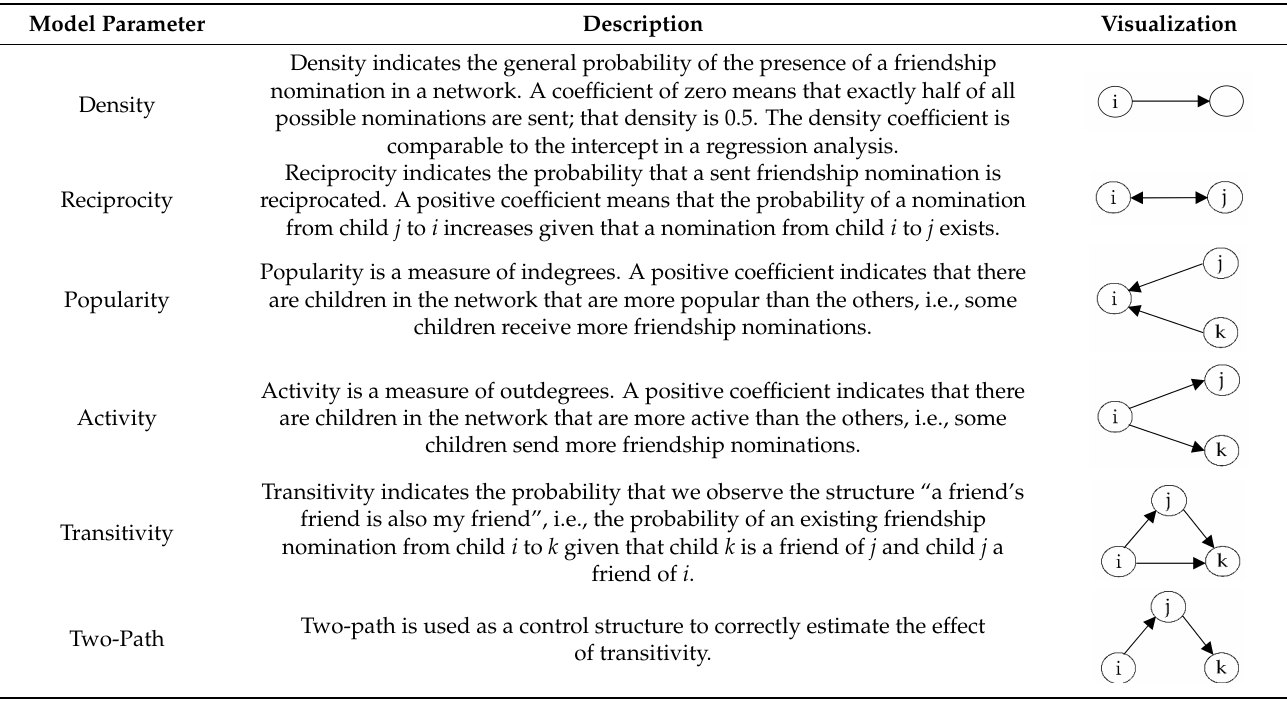
Table 2. Endogenous